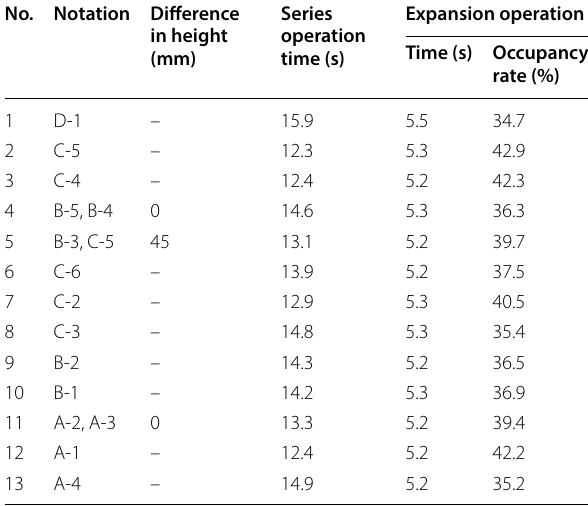
Table 9 Continuous unloading experiment results ④ No. Notation Difference in